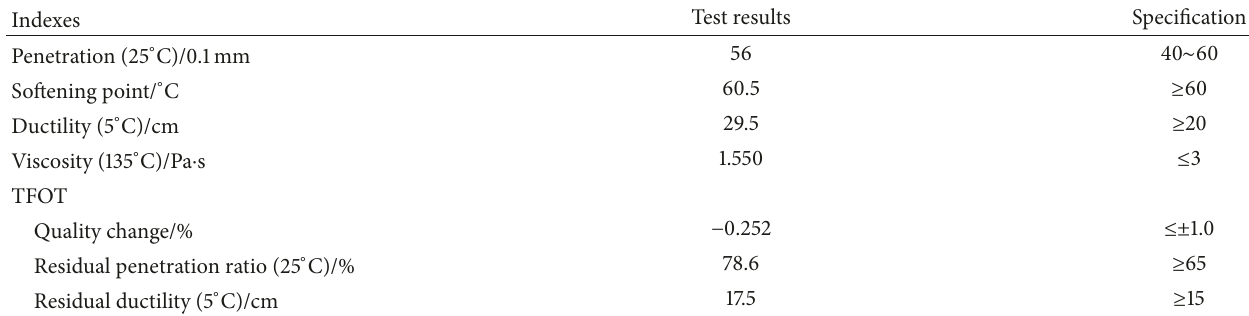
Table 2: Main technical indexes of modified